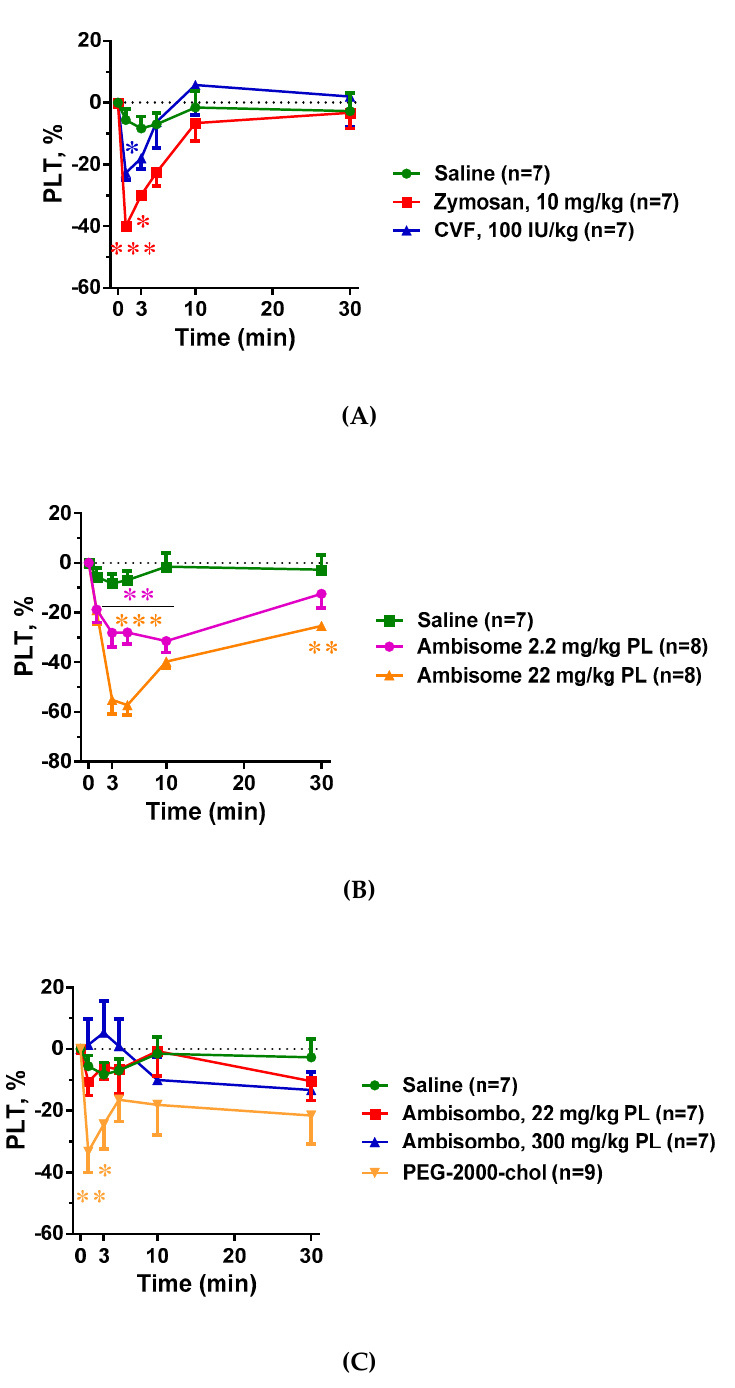
Figure 3. Effects of direct complement activators ( A ), amphotericin B-containing ( B ), and empty liposomes ( C ) on plasma platelet (PLT) counts in anesthetized rats. The doses and number of animals are specified in the keys. The data show percentages of change relative to baseline (t = 0 min), mean ± SEM. Statistical analysis was performed using two-way repeated measurements ANOVA followed by Dunnett’s multiple comparisons post-hoc test. Significant differences (* = p < 0.05; ** = p < 0.01; *** = p < 0.001) are shown relative to the group treated with saline.